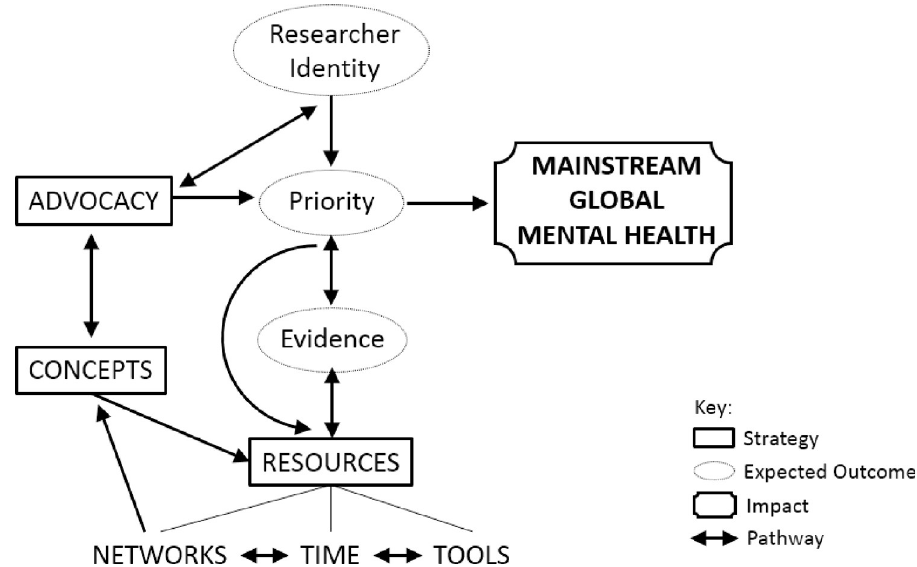
Fig 1. Theory of change to promote mainstreaming mental health in global challenges